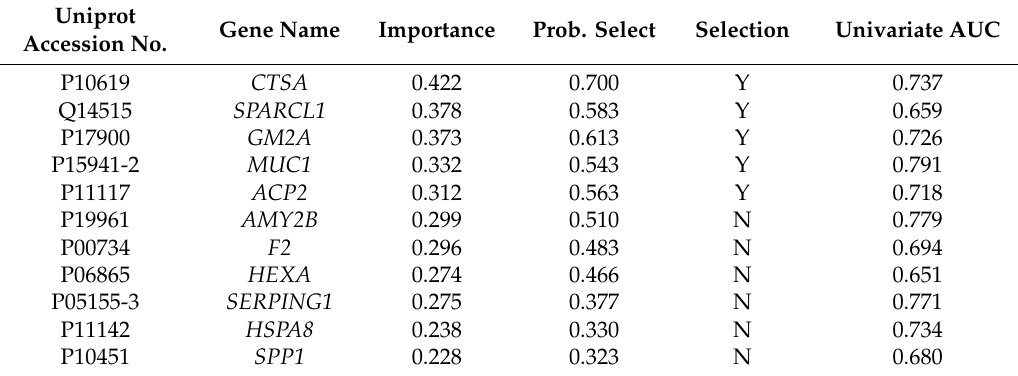
Table 2. AUC-based RF backward-elimination process-based selected feature